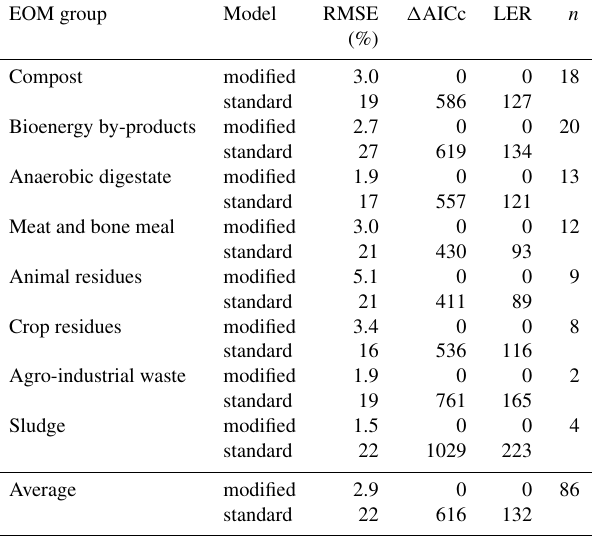
Table 6. Values for the root mean square error (RMSE), (cid:49) AICc and LER (logarithm of evidence ratio) of the respiration curve fitting performed with standard and modified RothC. EOM group